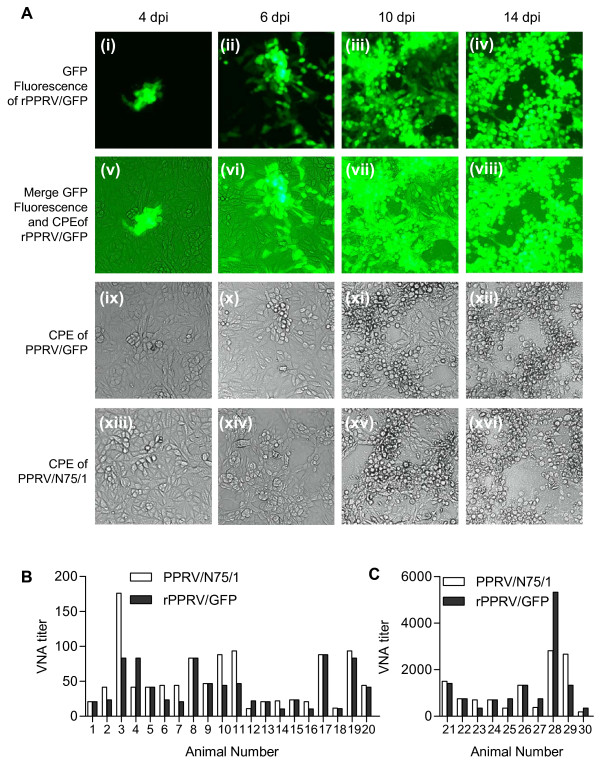
Comparison of PPR virus neutralization test using rPPRV/GFP and PPRV/N75/1. (A) Detection of virus replication during VNT assay. Serum from a goat (no. 31) previously vaccinated with 107 TCID50 PPRV/N75/1 was tested using either rPPRV/GFP or PPRV/N75/1. The GFP fluorescence ((i) to (iv)) and CPE ((ix) to (xii)) of rPPRV/GFP or the CPE of PPRV/N75/1 ((xiii) to (xvi)) after treatment with diluted serum (320-fold) were observed at 4, 6, 10 and 14 d post-infection. (B) Twenty PPRV-positive sera from rCPV-PPRVH vaccinated goats (nos. 1–10) or sheep (nos. 11–20) were assayed for PPR VNA titer using PPRV/N75/1 and rPPRV/GFP. (C) Ten positive sera from PPRV/N75/1 vaccinated goats (nos. 21–30) were assayed in the same manner as above. The results from assays with the two viruses were compared using a paired t test, and no significant difference seen